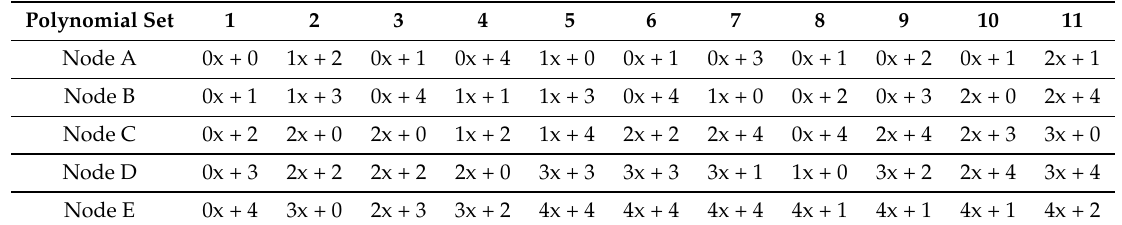
Table 1. The particular polynomial sets used in the experiments.